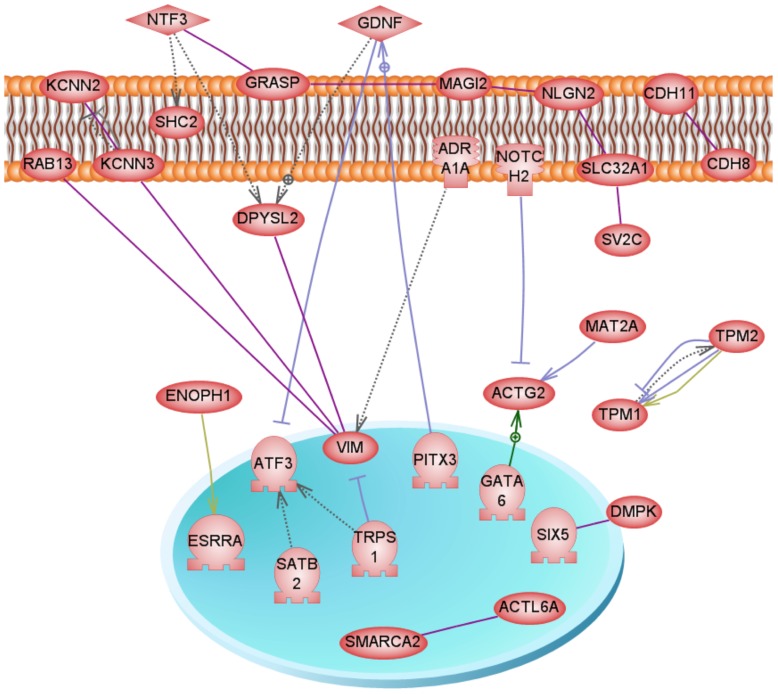
Gene network analysis for differential DNA methylation regions(DMR) associated genes in the F3 generation plastics lineage sperm. Direct connection (functional or binding) genes are shown according to their location in the cell. Genes not shown are not connected. Node shapes code: oval and circle – protein; diamond – ligand; circle/oval on tripod platform – transcription factor; ice cream cone – receptor. Arrows with plus sign show positive regulation/activation, arrows with minus sign – negative regulation/inhibition; gray arrows represent regulation, lilac – expression, purple – binding, green – promoter binding, and yellow – protein modification.